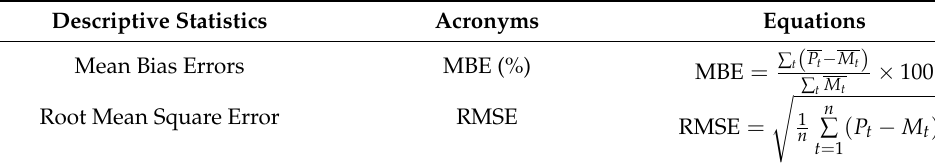
Table 3. Summary of descriptive statistics used for the analysis. Descriptive Statistics